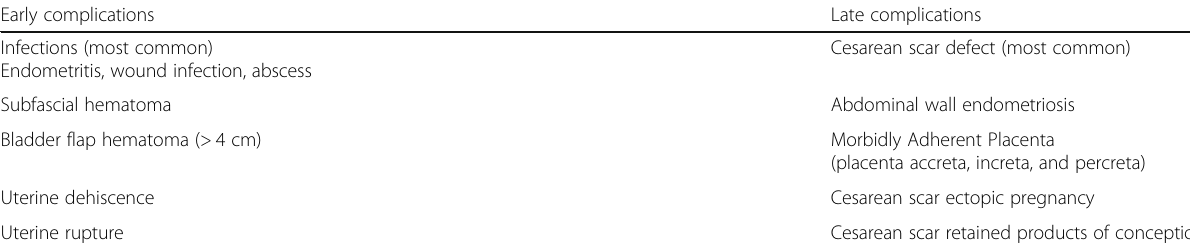
Table 2 Acute and chronic caesarean delivery complications (adapted from [1]) Early